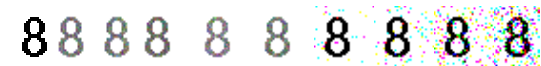
Fig. 8 Example of sample